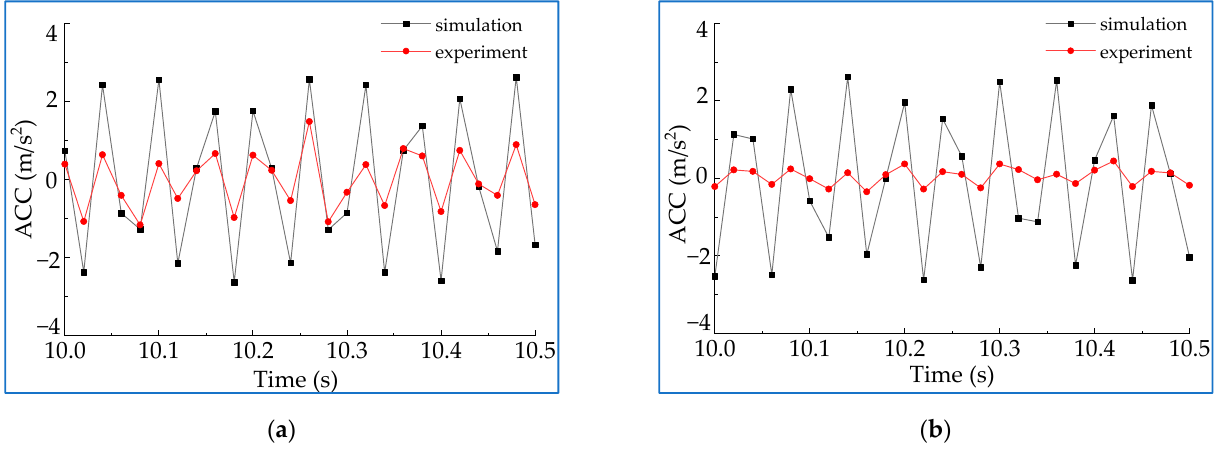
Figure 14. ( a ) Comparison of vibration acceleration amplitudes in the direction between rollers. ( b ) Comparison of vibration acceleration amplitudes in the direction of gravity.